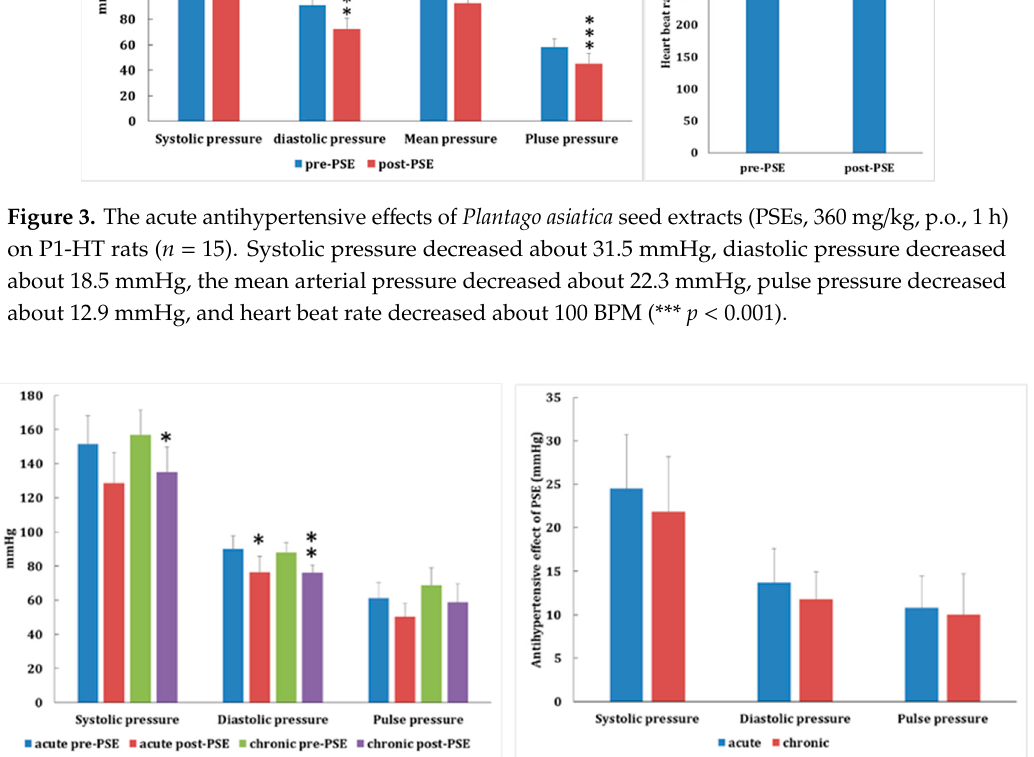
Figure 4. The one-time acute and chronic antihypertensive effects of Plantago asiatica seed extracts (PSEs, 360 mg/kg, p.o,, 4 weeks) on P1-HT rats ( n = 5). The antihypertensive effects after 4 weeks of continuous PSE oral administration were not significantly different from the first time PSE administration. This result showed that continuous oral administration did not negate the antihypertensive effects of PSE treatment (* p < 0.05, ** p < 0.01). 3. Discussion In spontaneously hypertensive animals, such as SHR rats, the plasma levels of angiotensin II, endothelin 1 (ET-1), malonaldehyde (MDA), interleukin 6 (IL-6), tumor necrosis factor alpha